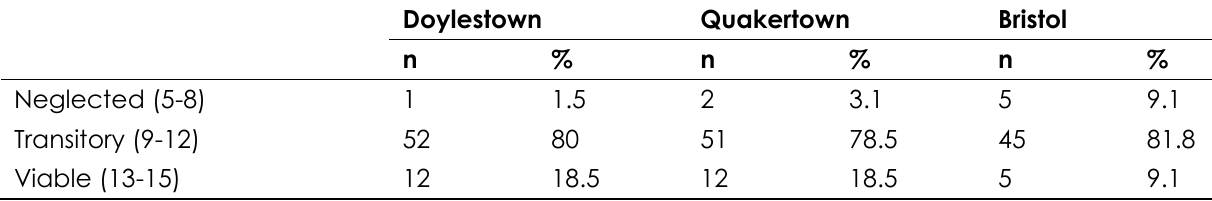
Table 3. Neglected and viable structures per town.